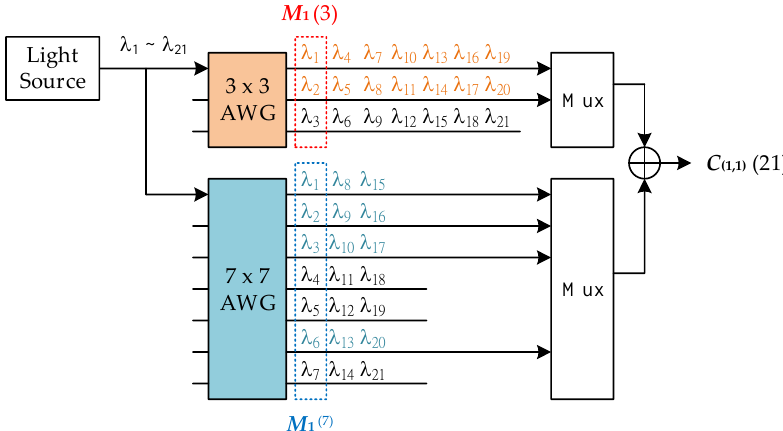
Figure 3. The encoder architecture of CMLS C (1,1) (21) based on arrayed waveguide grating (AWG). Mux: Multiplexer.